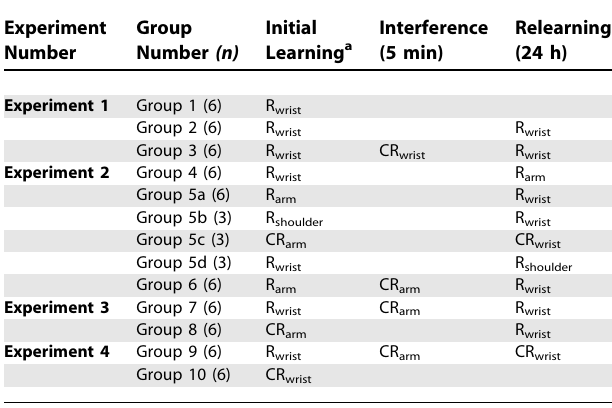
Table 1. Participant Groups and Experimental Protocol